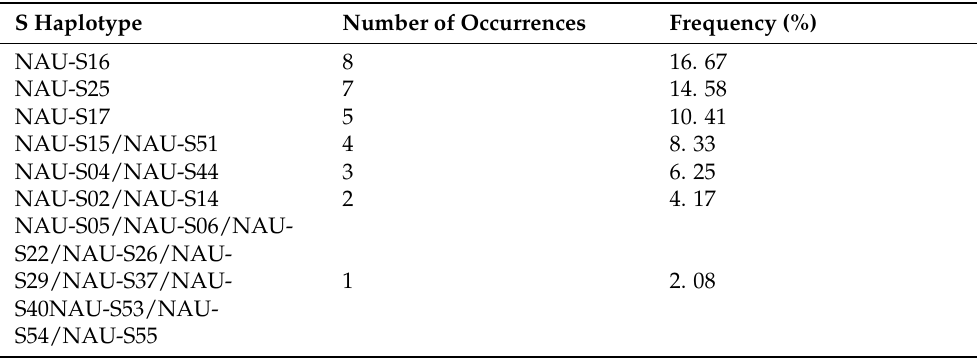
Table 3. S haplotypes frequencies among 48 Class I radish materials.